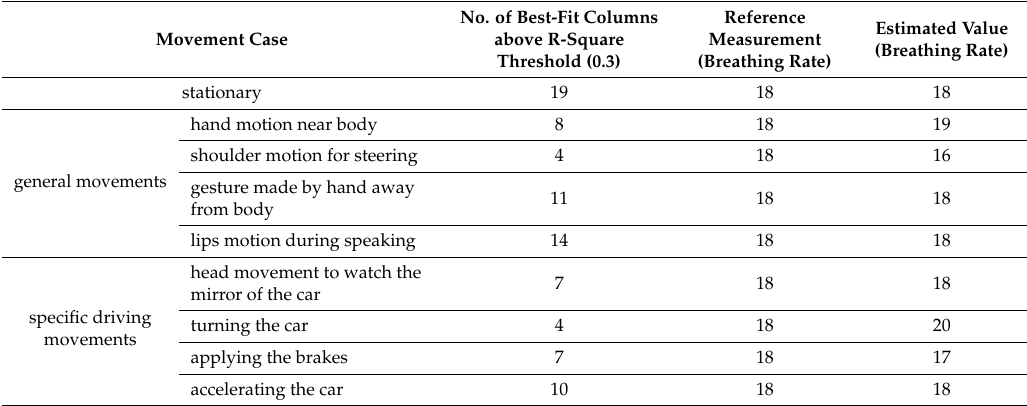
Table 1. Experimental results for breathing rate for different motion conditions.